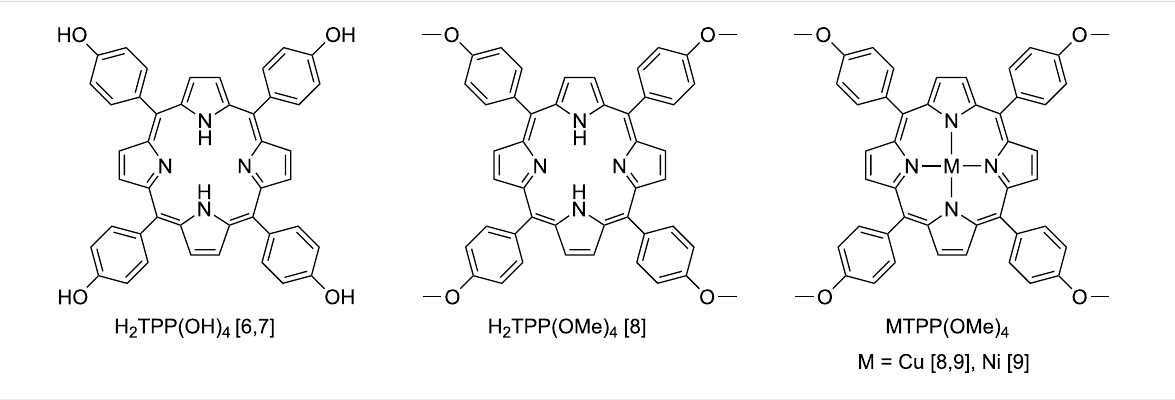
Figure 1: Chemical structures of porphyrins and metalloporphyrins successfully deposited by organic molecular beam deposition.